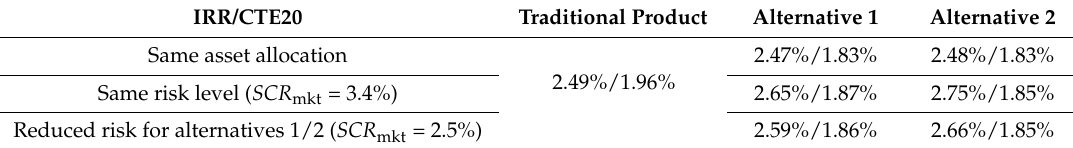
Table 4. IRR and CTE20 for products with the same asset allocation , with the same SCR mkt , and with reduced SCR mkt for alternative products, based on the traditional product with q “ 5% ( PVFP = 3.62%).